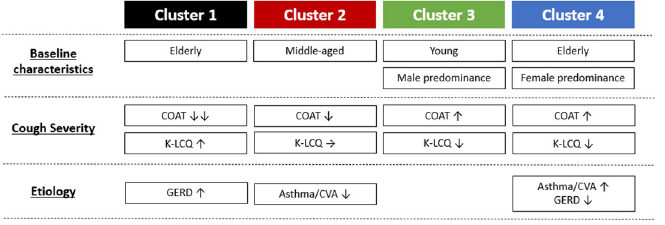
Fig 3. Summary of baseline characteristics, cough severities, and aetiologies among clusters. COAT, cough assessment test; K-LCQ, Korean version of Leicester cough questionnaire; CVA, cough variant asthma; GERD, gastroesophageal reflux